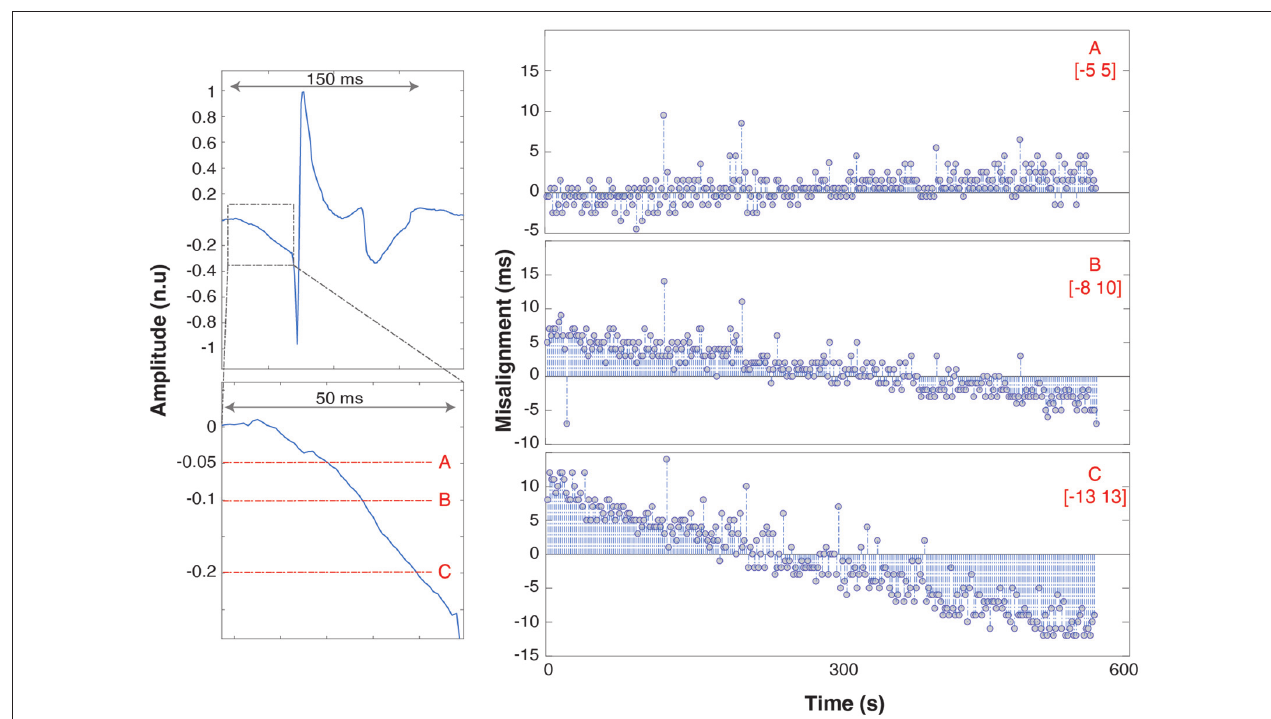
FIGURE 5 | Trend of spike misalignment throughout the recording respectively using threshold “A” (top row, right), “B” (middle row), “C” (bottom row). The range is underlined in red. The left panels show the full spike waveform (top left panel) and a zoom of the spike onset with 5%, 10% and 20% thresholds superimposed in red. The spike amplitude is shown with units normalized to the maximum waveform